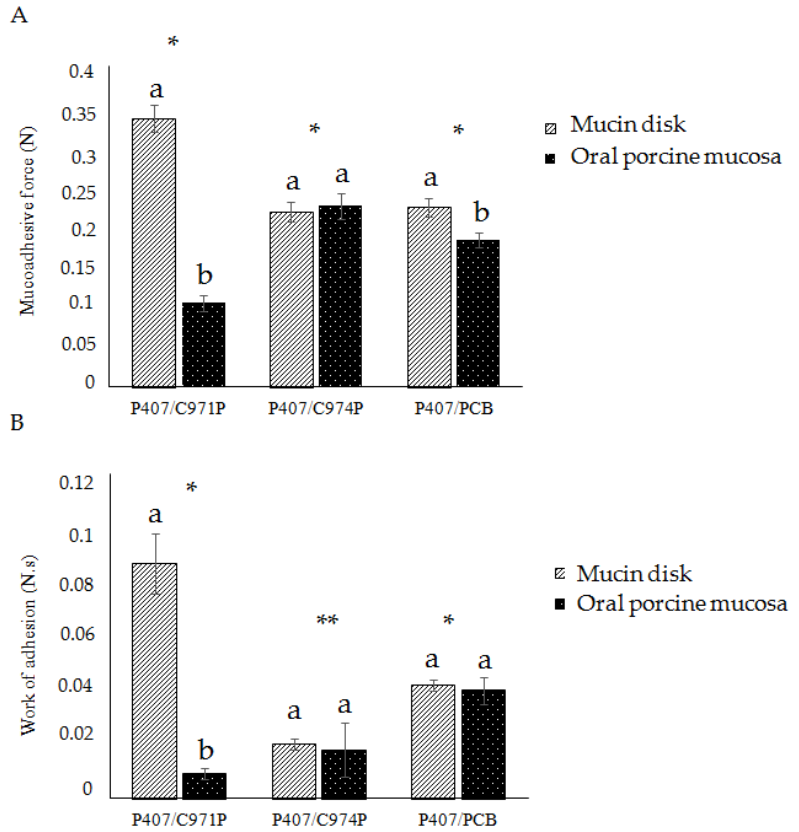
Figure 1. Mucoadhesive force F adh ( A ) and work of adhesion W adh ( B ) of the polymeric blends containing P407 and C971P, C974P, or PCB, obtained by detachment force method using porcine mucin disks or oral porcine mucosa as substrates. The symbols (* and **) and the letters (a and b) represent the significant difference ( p < 0.05) among the polymeric systems and the substrates, respectively.